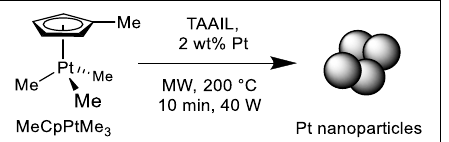
Table 1. Anion purity, IL purity, and decomposition temperature of TAAILs utilized in this work.